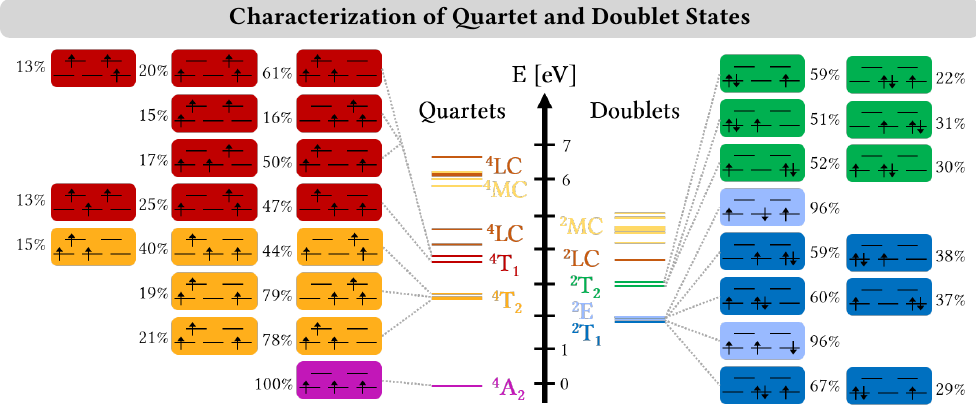
Figure 2. Energies and wave function characterization of quartet and doublet states of [Cr(ddpd) in water calculated at the CASPT2 level of theory. The lowest-lying states are metal-centered (MC) states and have been labeled using octahedral electronic term notation. States derived from the same terms are shown in the same color. Higher-lying MC and ligand-centered (LC) states are labeled as such in the middle of this figure and not distinguished further. Wave function characterization depicts the all configuration with weights > 10% in the MS-CASPT2 wave function, where the orbitals depict the three nonbonding t 2 g (lower levels) and two antibonding e ∗ g (upper levels) orbitals. More information about the further MC and LC states is given in Section S1 in the